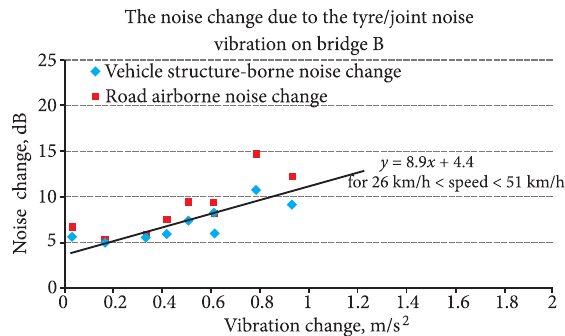
Fig. 14. The tyre/joint noises due to the tyre/joint vibration on Bridge B (using Acoustic-Box-in-Vehicle